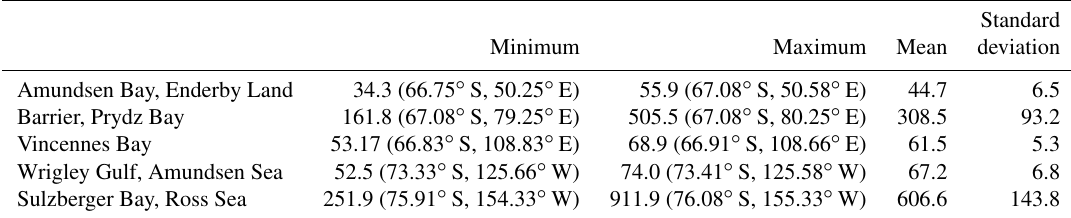
Table 3. Net primary production (mgCm − 2 d − 1 ) for some coastal polynyas around Antarctica in November 2017. The values in the paren- theses indicate locational